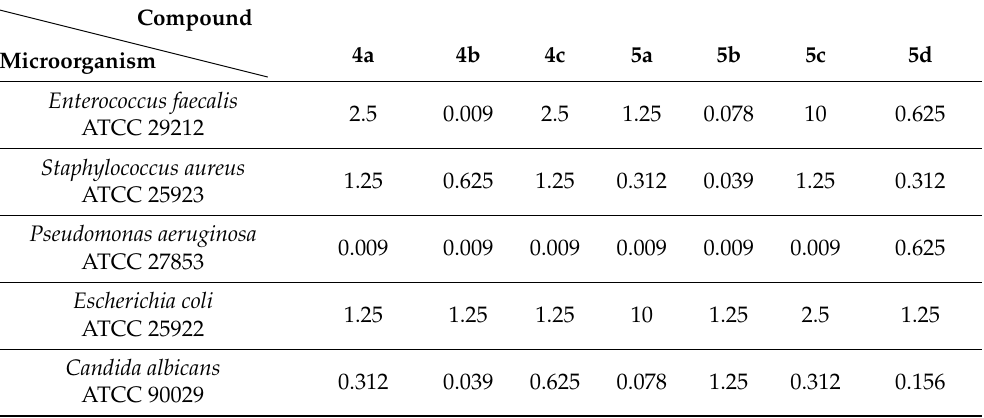
Table 3. MBEC (mg / mL) values for the compounds 4a – c , 5a – d